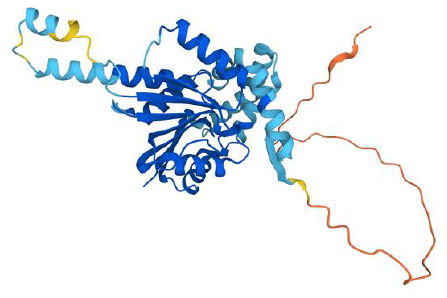
Figure 13. AlphaFold model of the COQ5 monomer. Model color corresponds to model confidence as described in Figure 4. Figure was generated by the AlphaFold Protein Structure Database; adapted with permission from [39,54].